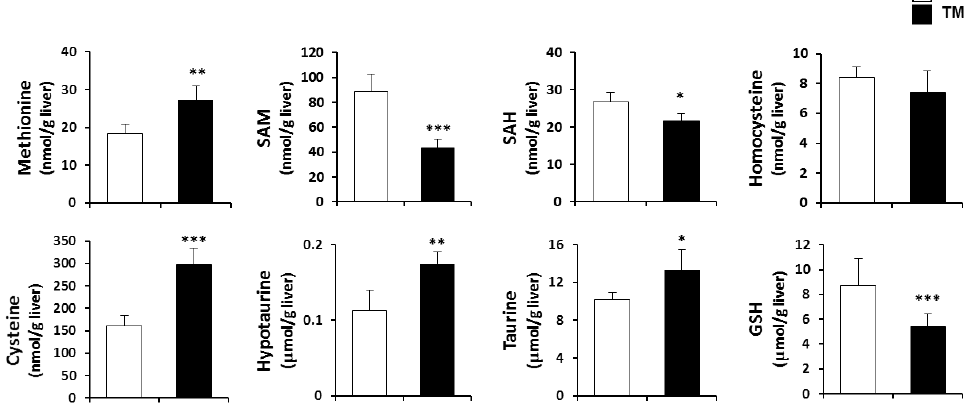
Figure 4. Changes in the hepatic sulfur containing substances by the TM treatment. Hepatic concentration of methionine, S-adenosylmethionine (SAM), S-adenosylhomocysteine (SAH), homocysteine, cysteine, hypotaurine, taurine, and glutathione (GSH) were measured in TM-treated mice (2 mg/kg body weight) using the analytic system of high-performance liquid chromatography (HPLC). Each value represents the mean ± SD. *, **, and *** Statistically significant difference between control (white) and TM-treated mice (black) at p < 0.05, < 0.01, and < 0.001, respectively (Student’s t -test).